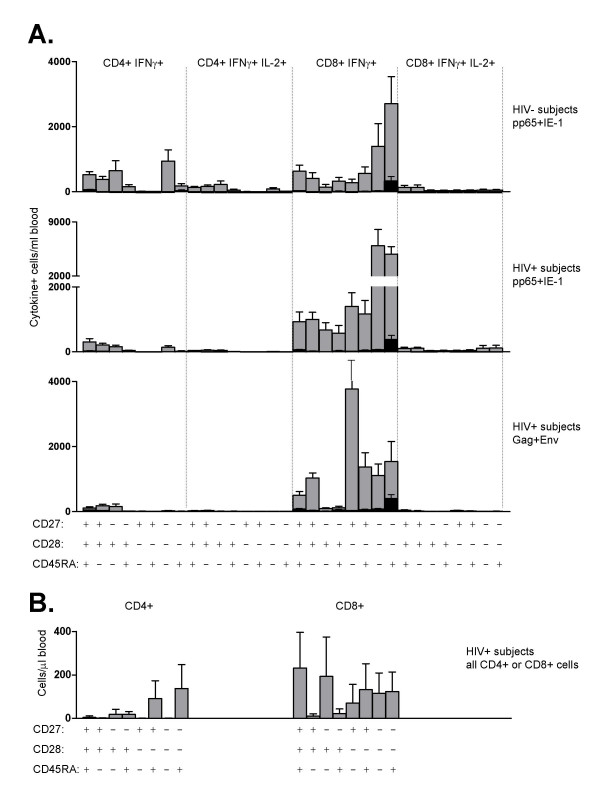
A: Individual phenotypic responses of HIV-negative and HIV-positive subjects to pp65+IE-1 or Gag+Env stimulation. Grey bars represent the mean (for 20 HIV-negative or 19 HIV-positive subjects) of the absolute number of cells for each of the 32 phenotypes, as listed at the bottom of the figure. Black bars represent the background, as mean of the absolute number of cytokine-positive cells in the unstimulated samples, for each phenotype. In both cases, error bars represent SEM. Phenotypes are grouped horizontally as CD4+ or CD8+, and by their cytokine profile. Within each subgroup, phenotypes are arranged from naïve (left) to terminal effector (right), with intermediates arranged by order of potential for IL-2 production in healthy donors (see Figure 6, top panel). Results are shown for the response of HIV-negative subjects to pp65+IE-1 stimulation (top), the response of HIV-positive subjects to pp65+IE-1 stimulation (middle), and the response of HIV-positive subjects to Gag+Env stimulation (bottom). B: Individual phenotypes of total CD4+ or CD8+ T cells. Each bar represents the mean (for 19 HIV-positive subjects) of the absolute number of cells displaying each of the phenotypes, as listed at the bottom of the figure. Error bars represent SEM. Results are shown for HIV-positive patient PBMC stimulated with Gag+Env peptide mix, for direct comparison to the HIV-specific response shown in A.